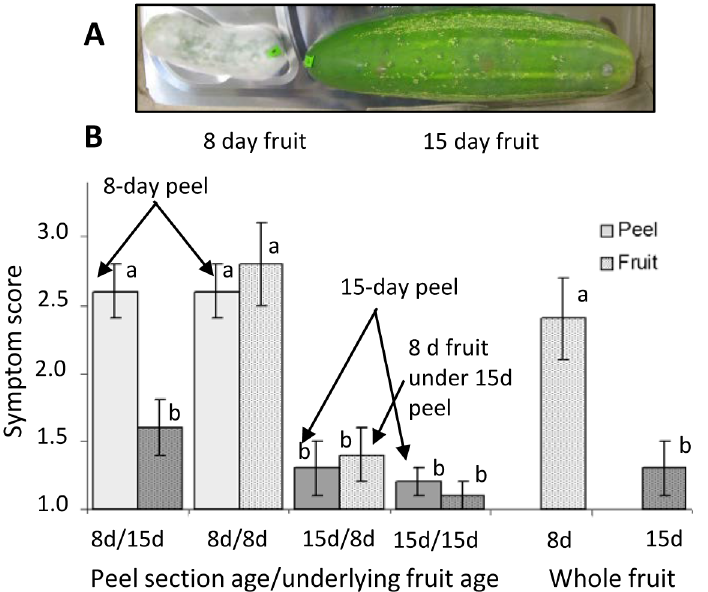
Fig 1. Phytophthora capsici disease development on cucumber fruit and peels. (A) Pathogen growth on whole, unwounded cucumber fruit. Fruit were harvested at 8 or 15 days post pollination (dpp) and inoculated with zoospore suspensions of P . capsisi . The photograph was taken at 5 days post-inoculation. The 8 dpp fruit is covered with mycelial growth. (B) Disease development on peel sections and underlying fruit, or directly inoculated whole fruit as described in methods. x/y indicates age of overlying peel section/age of underlying intact fruit. Symptom score: 1 = no symptoms or localized necrosis; 2 = water soaking; 3 = sporulation. Each value is the mean of at least 9 fruit ± SE . Bars marked with different letters indicate significant different, ANOVA, LSD, P < 0.05.